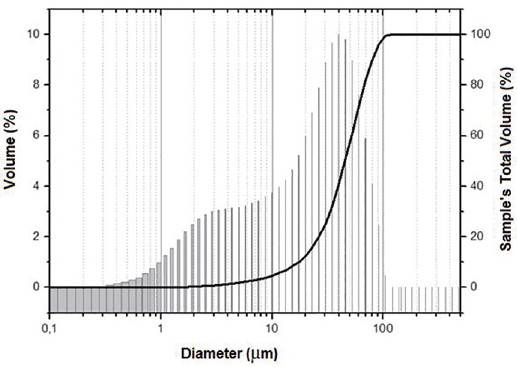
Figure 5: Biphasic powder particle size